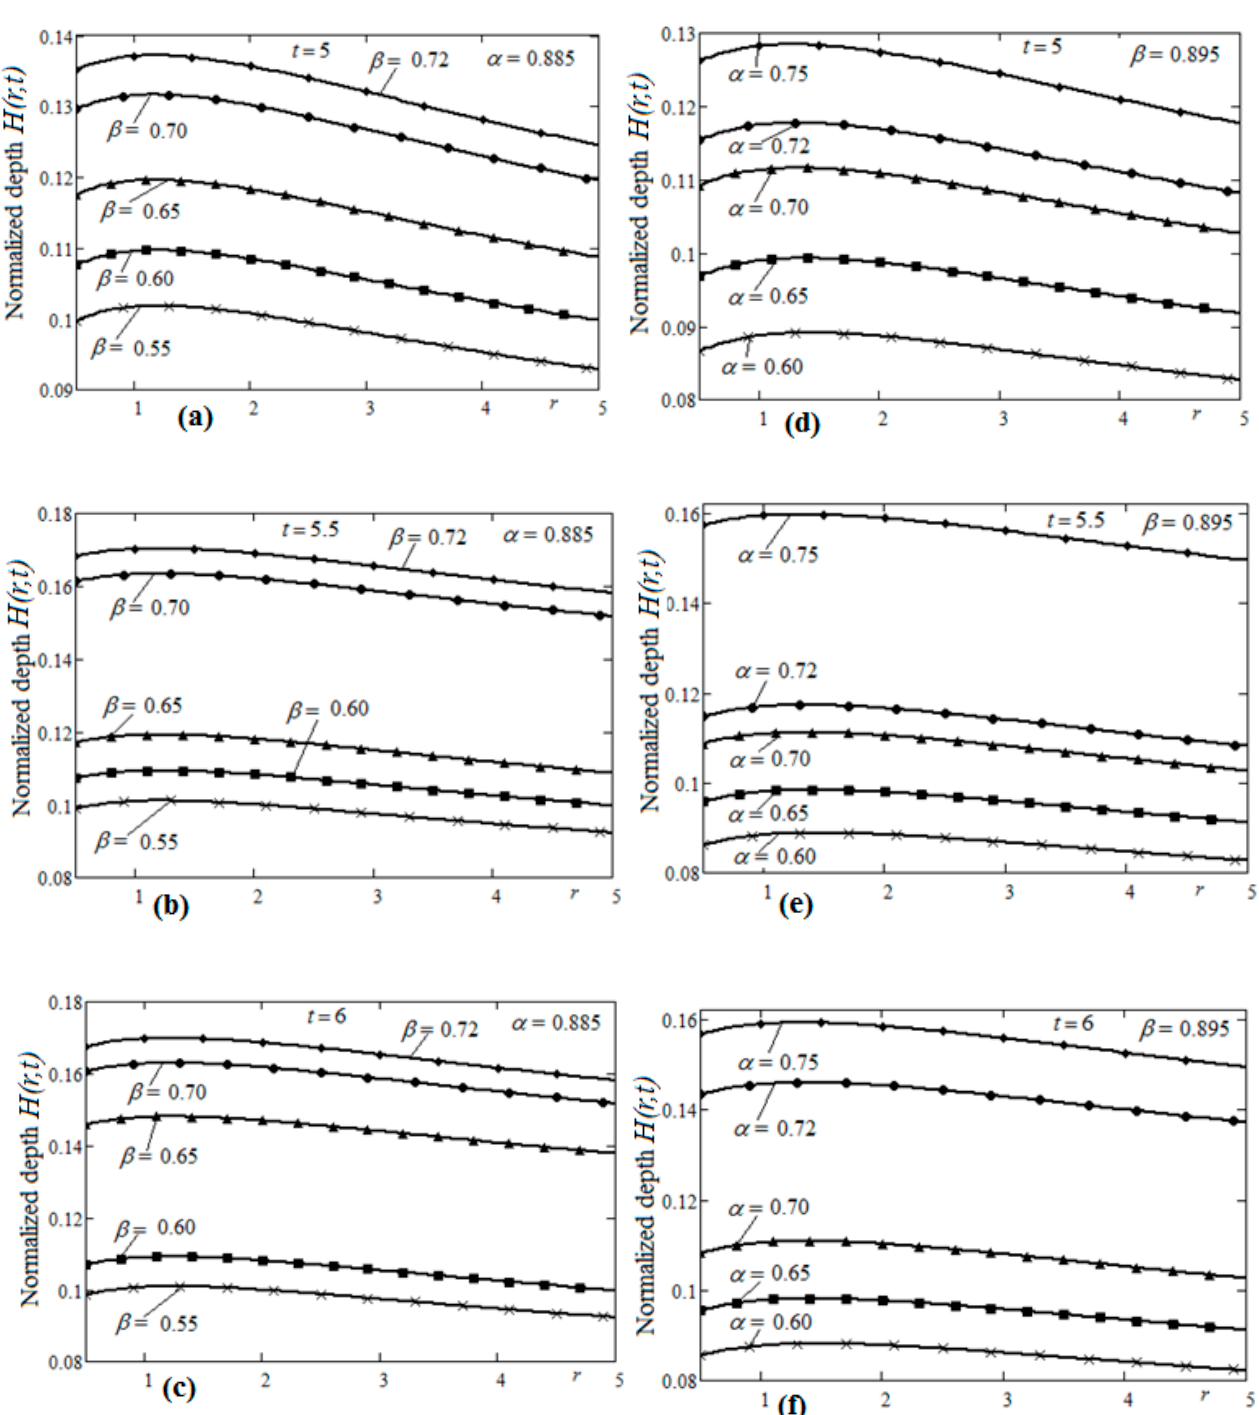
Figure 2. The influence of the fractional parameters β (figures ( a – c )), and α (figures ( d – f )) on the normalized H ( r , t ) .